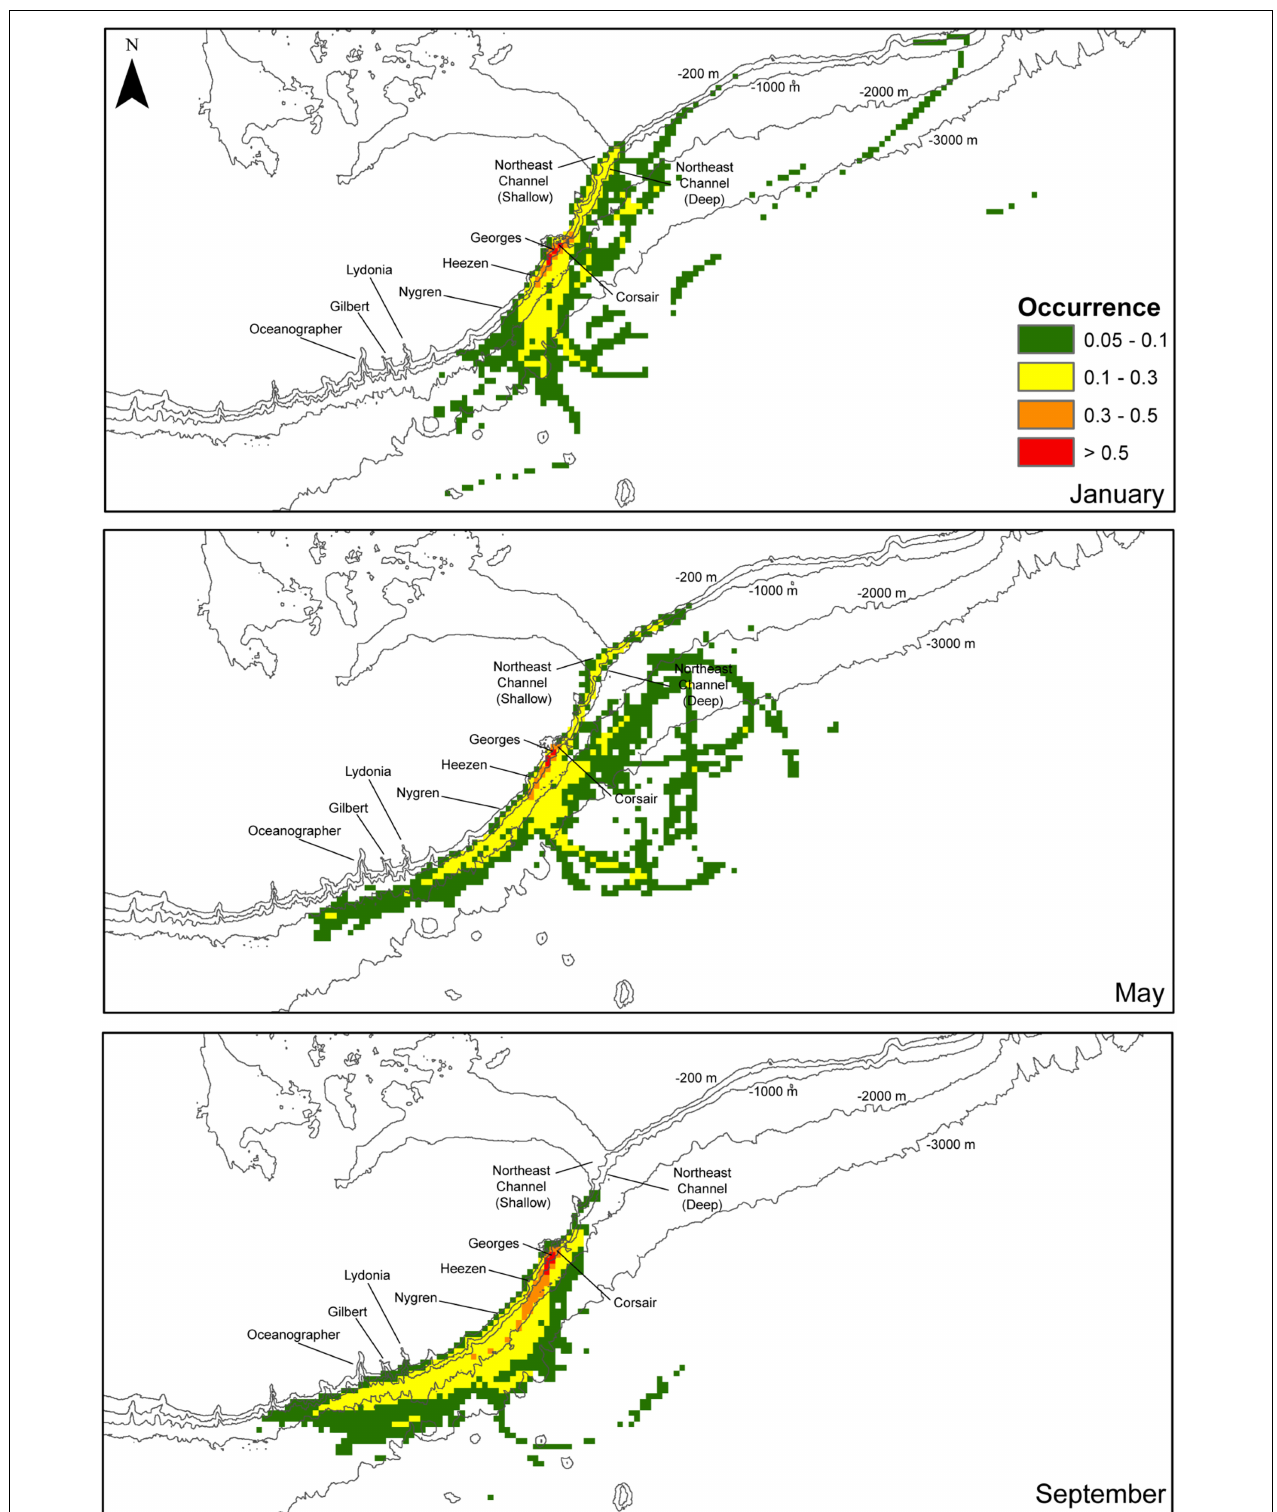
FIGURE 11 | Fraction of the total number of tracks (0–1) of all tracks in the region surrounding the mouth of Corsair Canyon over the maximum temporal length of release (60 d) segregated by month: January, May, and September (total of 750 tracks for each month). Densities were computed on a 5 km × 5 km grid. Fractions below 0.05 are not